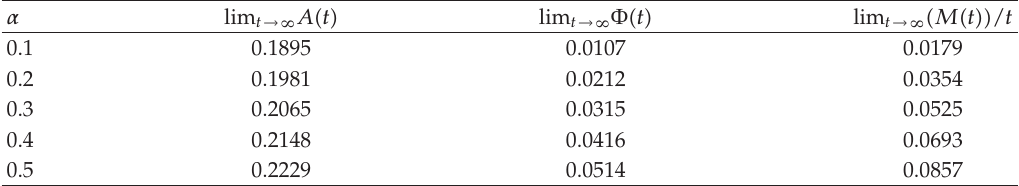
Table 2: Reliability indices for varying value of α with (cid:2) E (cid:2) Y (cid:5) ,E (cid:2) B (cid:5)(cid:5) (cid:8) (cid:2) 0 . 5 , 0 . 6 (cid:5) .